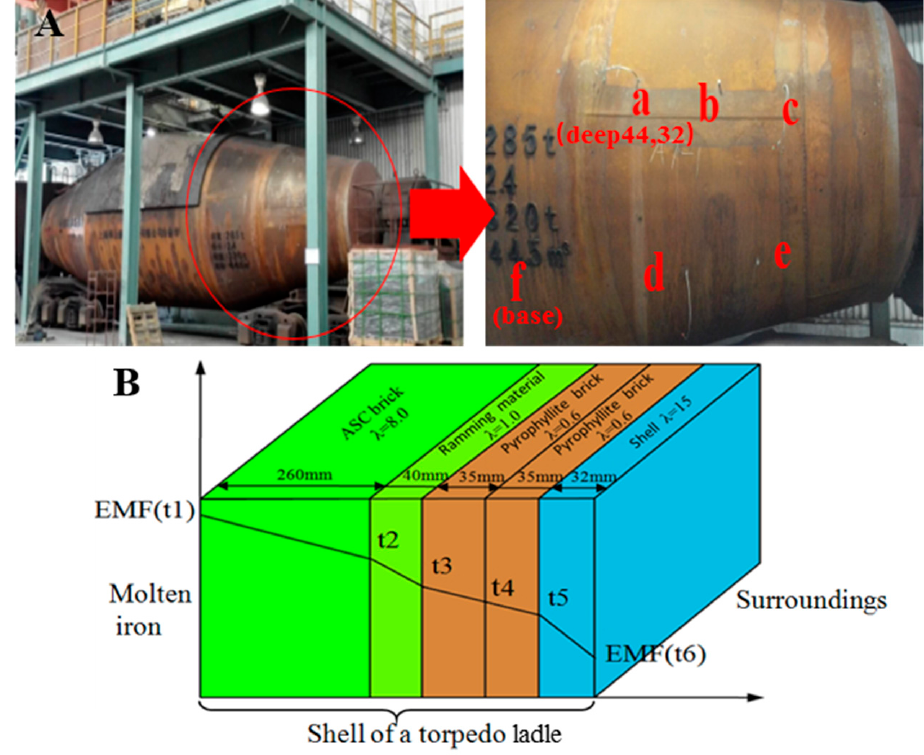
Figure 4. EMF experiments and sensor locations in the shell of a 285 t torpedo ladle: ( A ) EMF locations of a , b , c , d , e , and f on the shell and ( B ) properties of each refractory layer from Al 2 O 3 -SiC-C (ASC) brick to steel shell).